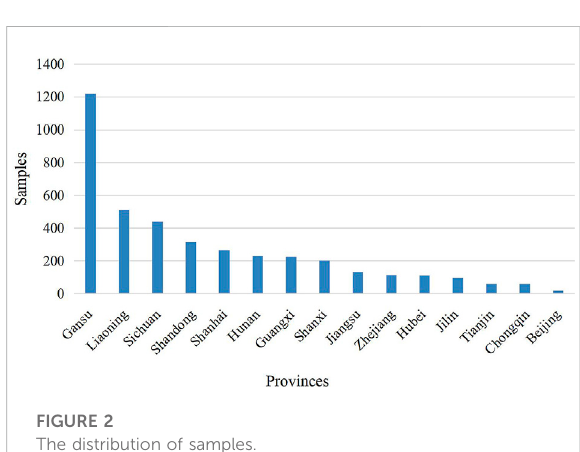
FIGURE 2 The distribution of